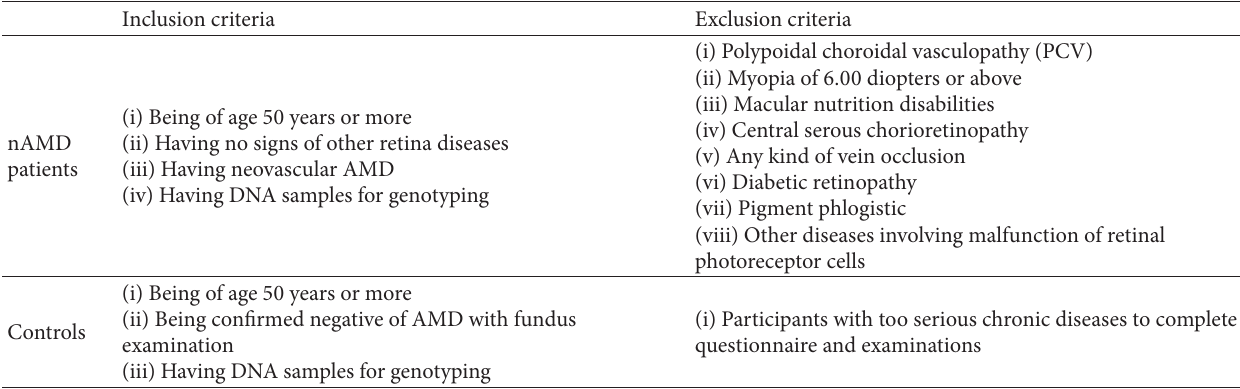
Table 1: Inclusion and exclusion